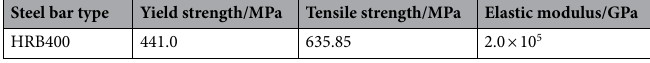
Table 2. Mechanical property of steel